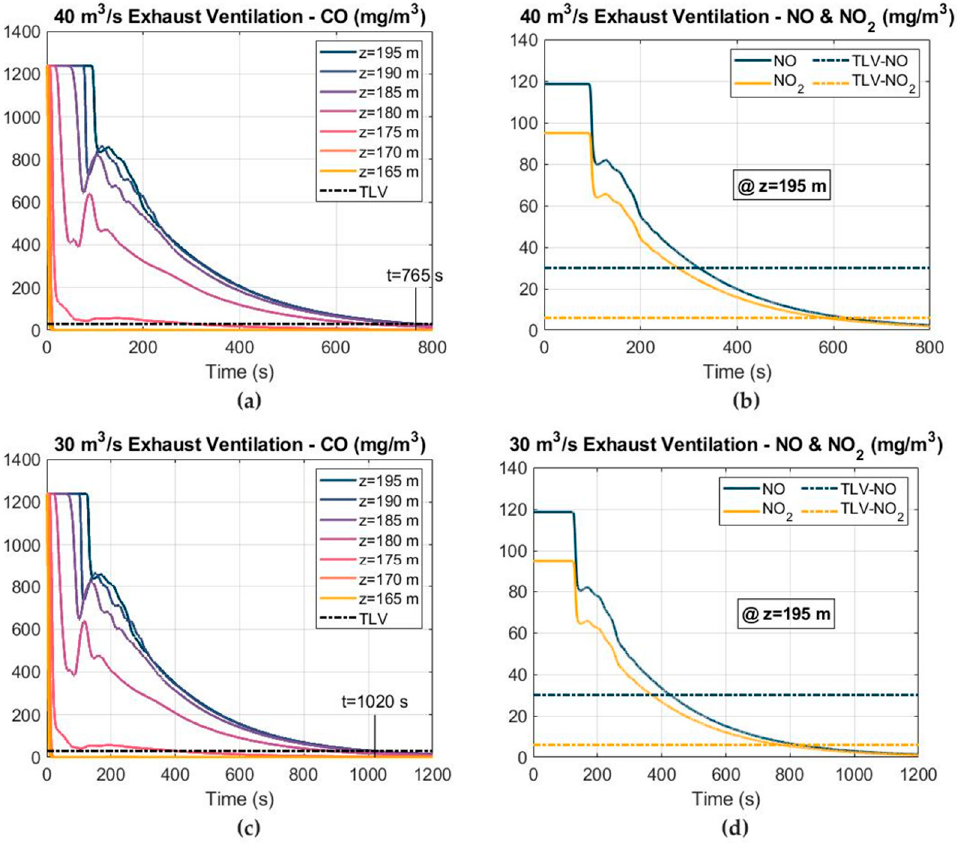
Figure 18. Distribution of the toxic gas mass concentrations and TLVs at different cross sections, under exhaust ventilation and using airflows of 30 and 40 m 3 s − 1 : ( a ) CO mass concentration at 40 m 3 s − 1 ; ( b ) NO and NO 2 mass concentrations at 40 m 3 s − 1 ; ( c ) CO mass concentration at 30 m 3 s − 1 ; and ( d ) NO and NO 2 mass concentrations at 30 m 3 s − 1 .